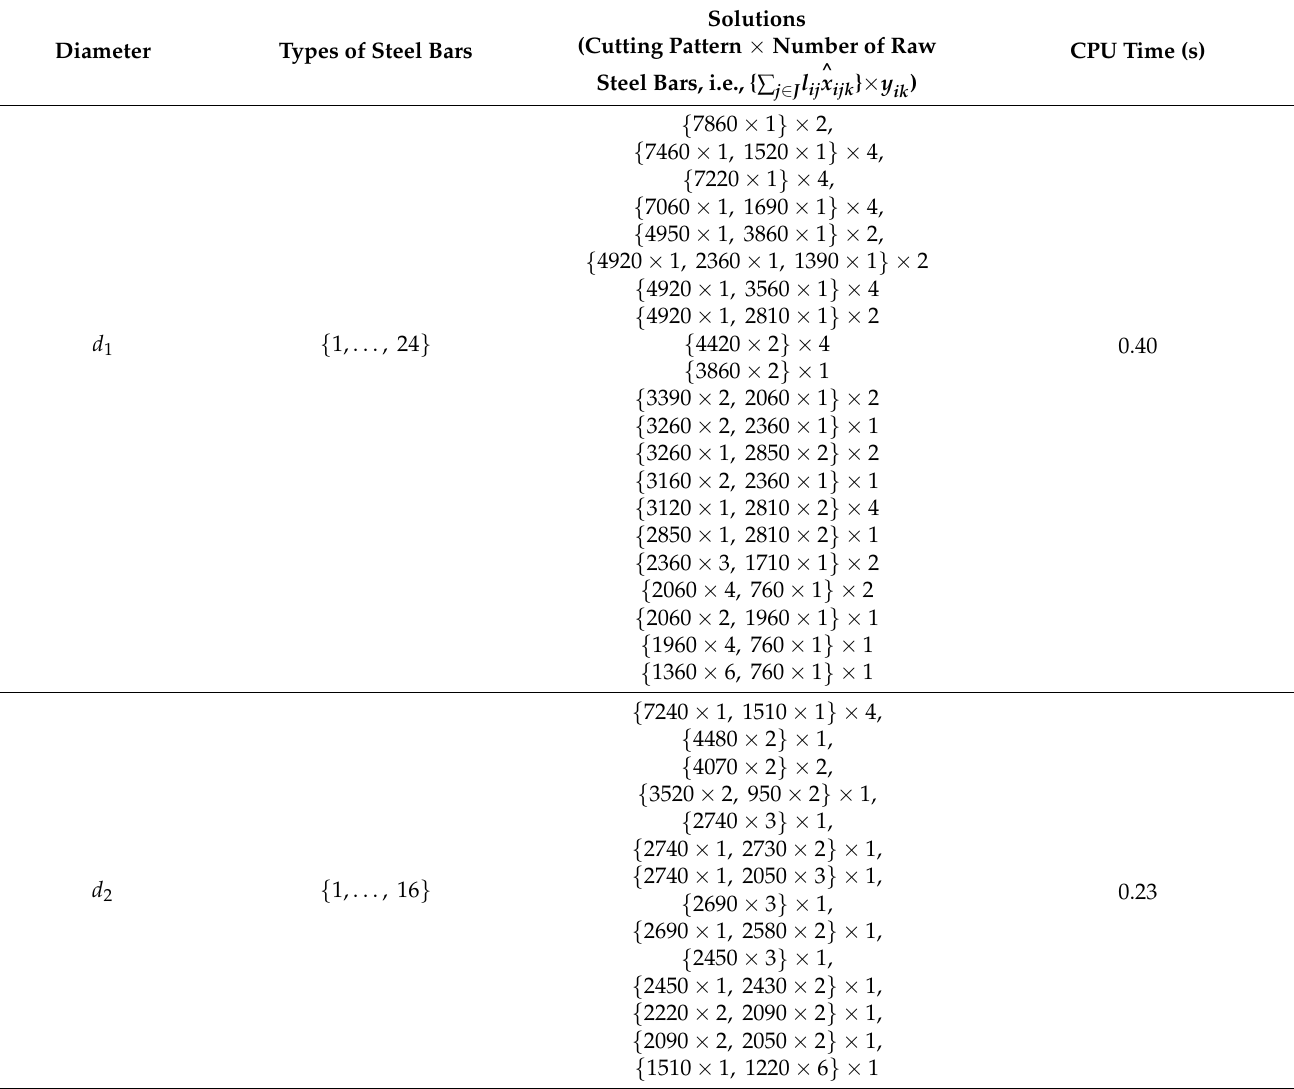
Table 6. Data for the required numbers of steel bars of diameter 12 mm and diameter 18 mm.